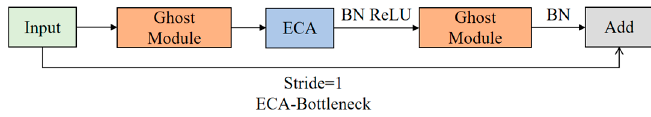
Figure 7. Improved ECA–Bottleneck module.